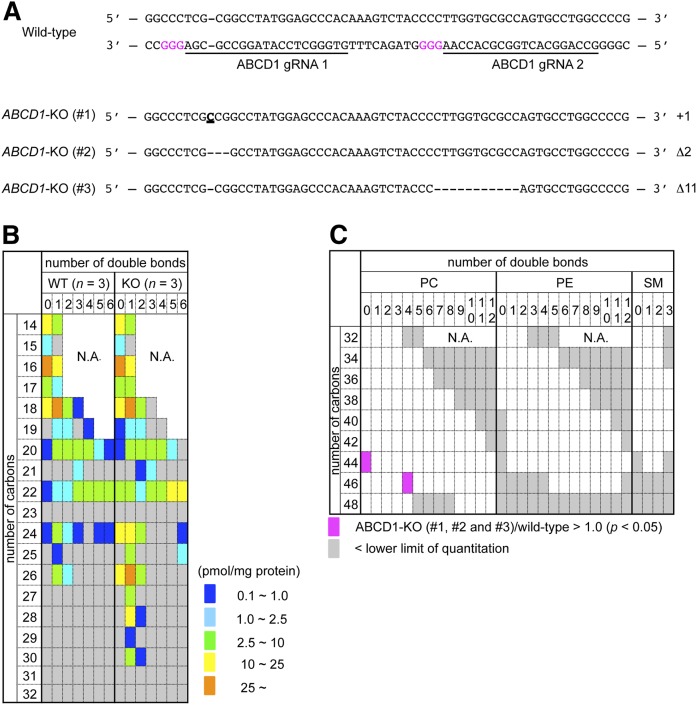
Quantity of each acyl-CoA species in the ABCD1-KO HeLa cells. A: Generation of ABCD1-KO HeLa cells with the CRISPR/Cas9 system. Partial genomic sequences for ABCD1 are shown. The 20 bp target sequences of the gRNA are underlined. The protospacer adjacent motif (PAM) is represented in magenta. The bold and underlined nucleotide represents an insertion (#1), while the dashes (#2 and #3) represent deletions. These mutations all result in a frameshift and ABCD1 KO. B: The quantity of each acyl-CoA species in the ABCD1-KO HeLa cell lines (#1 to #3) compared with three independent clones of WT HeLa cells. The ratio of peak area for each acyl-CoA/D31-16:0-CoA was used to calculate the amount of each acyl-CoA species and the mean quantity of each acyl-CoA species is represented with a color key. The data are also summarized in Table 4. Acyl-CoA species observed to be present below the quantitation range are indicated in gray. C: Each PC, PE, and SM species present in significantly higher quantities (magenta) in the ABCD1-KO HeLa cell lines (#1 to #3) compared with three independent clones of WT HeLa cells were classified according to the number of carbons and double bonds in the two acyl moieties. No PL species were present in significantly lower quantities than in the control. PL species observed to be present below the quantitation range are indicated in gray. The species for which there were no MRM channels designed are indicated as N.A. The quantity of each PL species in the ABCD1-KO HeLa cells is listed in supplemental Table S2